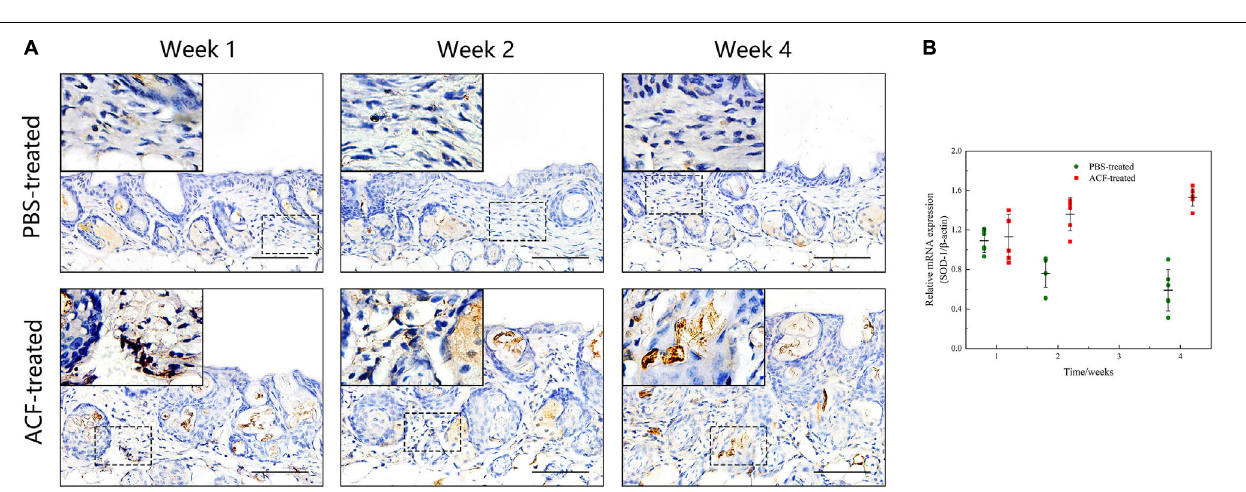
FIGURE 11 | ROS production of mouse skin samples of ACF-treated group and control group. (A) ROS production evaluated by dihydroethidium staining of both groups. A higher level of ROS was observed in the control group than in the ACF-treated group at each time point. (B) Semi-quantitative analysis of the ROS production in the dermis of both groups. P (week 1) = 3.081E-08, F (week 1) = 0.070; P (week 2) = 9.081E-10, F (week 2) = 0.560; P (week 4) = 4.837E-09, F (week 4) = 4.836E-09. Scale bar = 200 µ m.